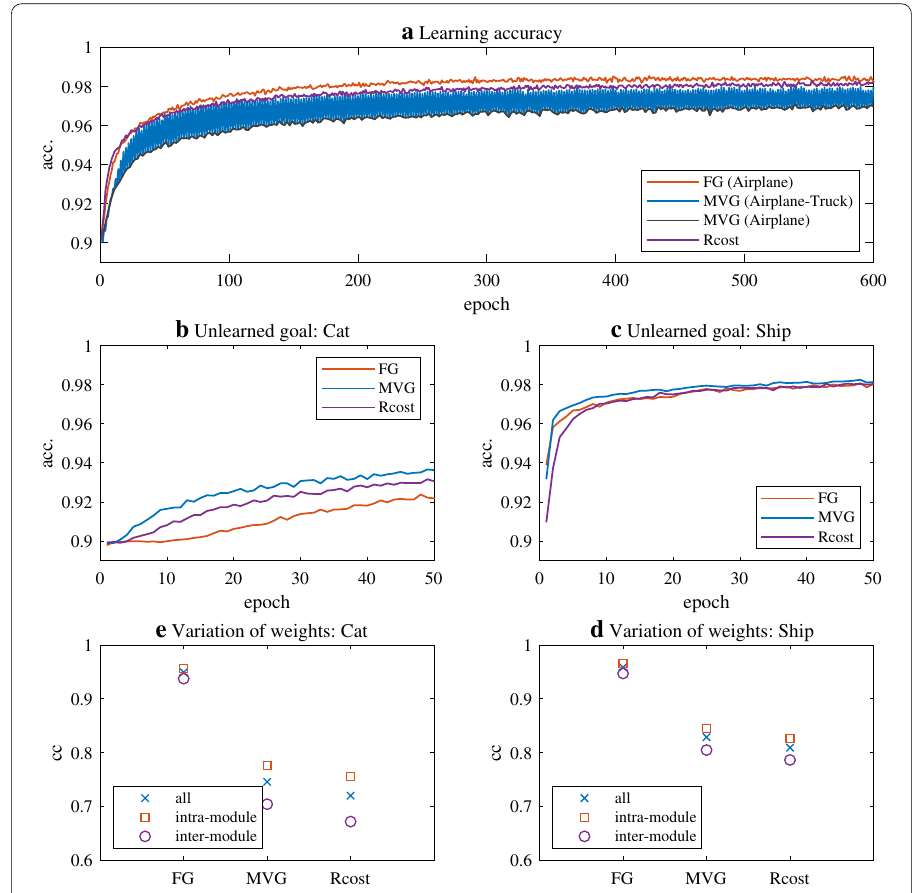
Fig. 2 Learning towards fixed and switching goals. a Categorical accuracy against the goal of learning. Blue indicates the MVG of Airplane and Truck. Blue line is a single line with high frequency. Y-axis is the accuracy of the learning goal. Black connects the epochs needed to learn Airplane in the MVG. Red indicates the FG of Airplane. Purple indicates Rcost. b , c Categorical accuracy against unlearned goals Cat and Ship. The weights of the initial neural network are from the last epoch of ( a ). e , d Pearson’s correlation coefficient (cc) against before and after learning unlearned goals Cat and Ship. The cc of the filter elements of the initial neural network and the last neural network in ( b , c ) are shown. Blue indicates the cc of all the filter elements. Red indicates the cc of elements in the filter corresponding to intra-module links. Purple indicates the cc of elements in the filter corresponding to inter-module